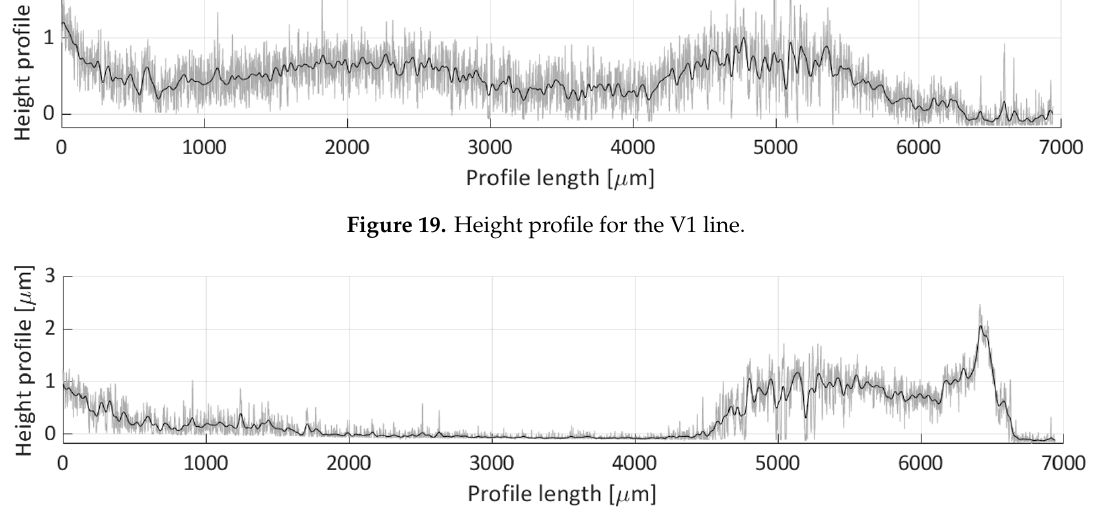
Figure 19. Height profile for the V1 line.